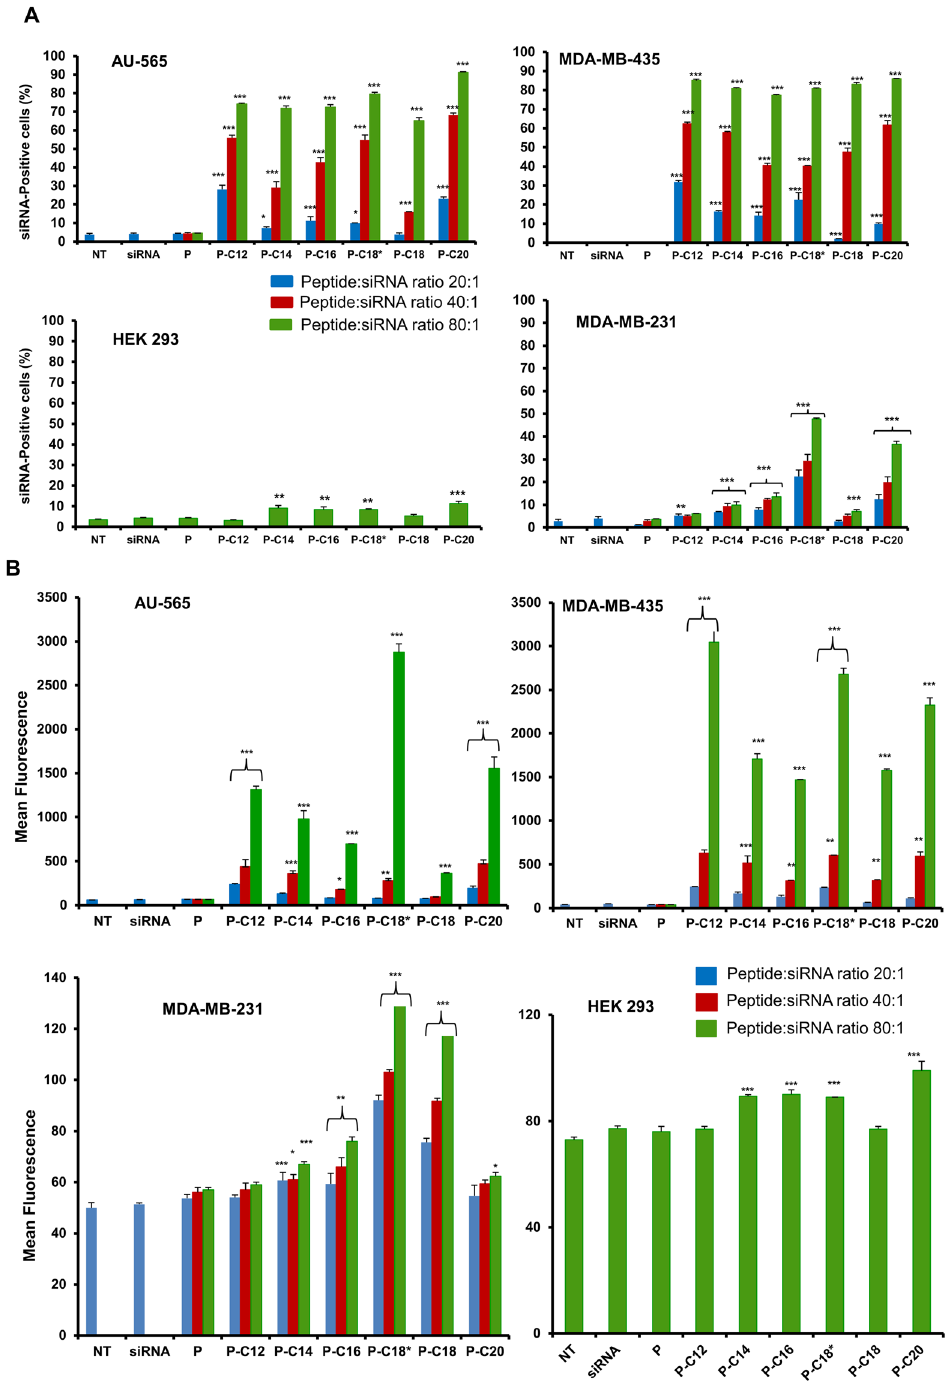
Figure 6. Cellular uptake of FAM-labelled siRNA. ( A) The percentage of siRNA-positive cells for all the studied peptides at different peptide:siRNA w/w ratios. Modified peptides showed a significantly enhanced uptake compared to unmodified CGKRK, which continuously increased with higher ratios. No significant uptake was observed in normal HEK293 cells; ( B ) The extent of cellular internalization is also presented as the mean fluorescence of the whole cell population, which demonstrates the differences in siRNA uptake more efficiently. Overall, the extent of uptake was lower in the MDA-MB-231 cells compared to the other cancer cells included in this experiment. Uptake in HEK293 cells was negligible. In all graphs, data is shown as Mean + D (n = 3). *** p < 0.001; ** p < 0.01; and * p < 0.05; calculated by the 2-way ANOVA with Bonferroni post-test using Graph pad Prism